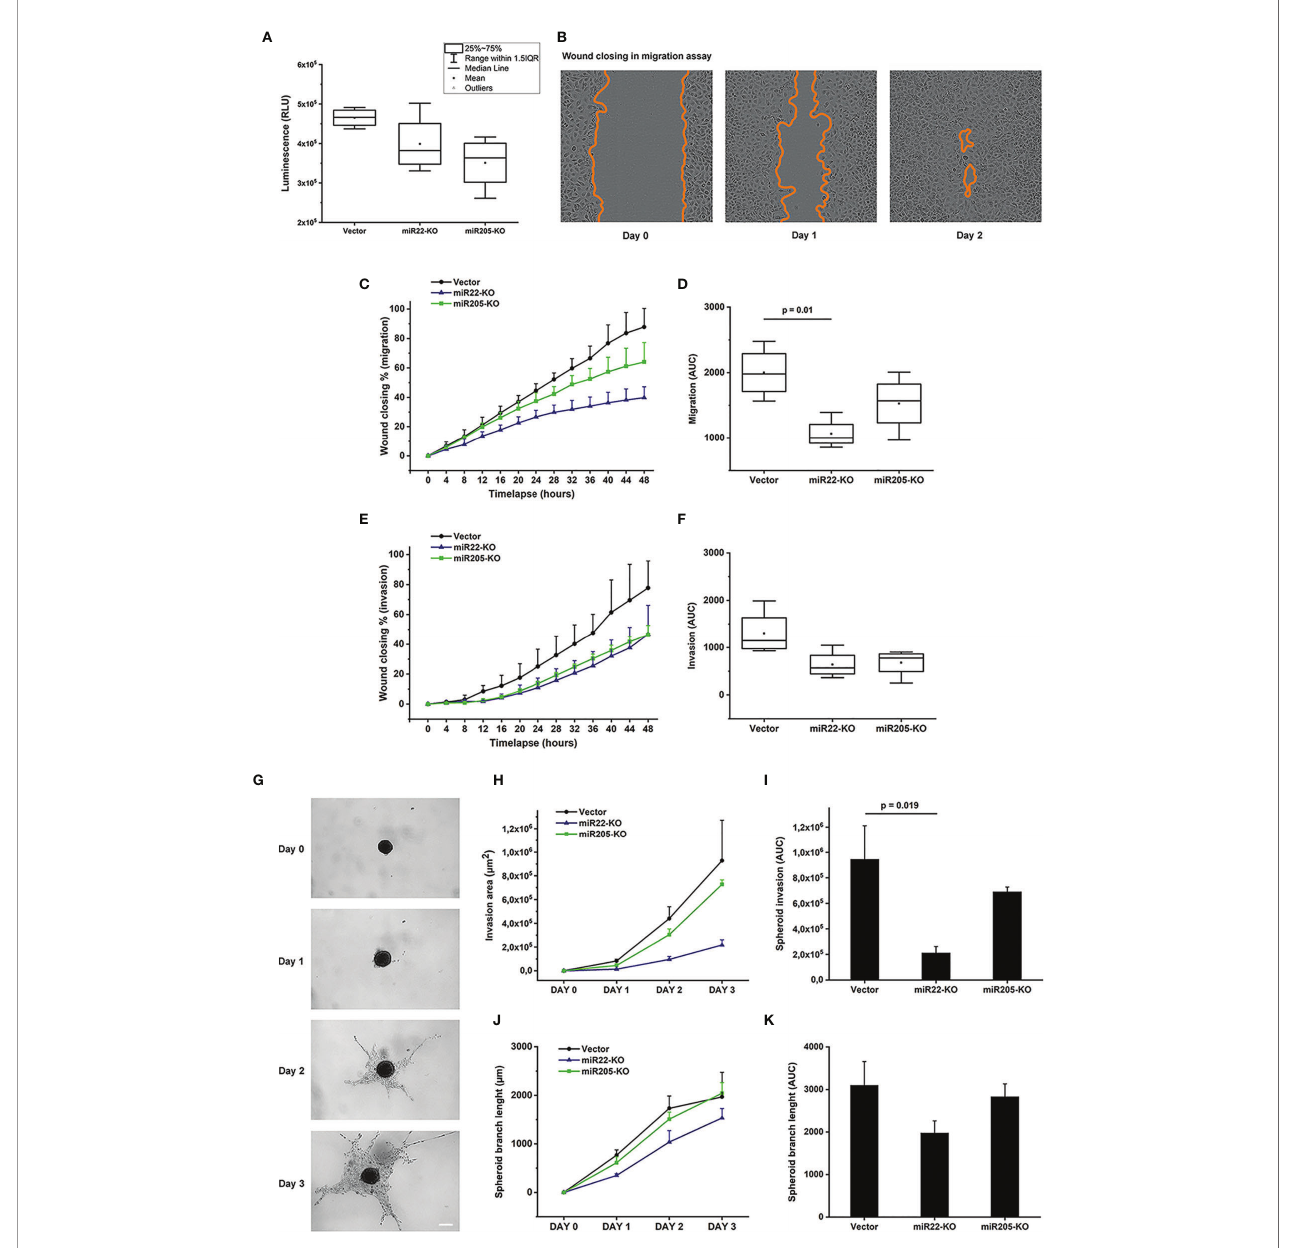
FIGURE 5 | Cell viability, migration and invasion assays performed using the UM-HMC-2 cell line. (A) UM-HMC-2 cells were cultured for three days and the cell viability was measured using luminescent cell viability assay. Although not statistically signi fi cant, the cell viability was decreased in both miR22- and miR205- knockout cell lines compared to the cell line transfected with an empty plasmid vector. (B – D) UM-HMC-2 cells were cultured on Myogel matrix and cell migration was evaluated using scratch wound cell migration assay. (B) Representative image of migration distance at 0, 24, and 48 hours after wounding. (C, D) Quanti fi cation of cell migration in scratch wound assay. miR22- and miR205-knockout cell lines migrated slower than the vector cell line. Statistically signi fi cant difference was denoted between vector and miR22-KO cell lines. (E, F) UM-HMC-2 cell invasion through Myogel-collagen in scratch wound cell invasion assay. UM-HMC-2 cells were cultured in Myogel-collagen matrix, and cell invasion was evaluated using scratch wound cell invasion assay. miR22- and miR205-knockout cell lines invaded slower than vector cell line (p-value > 0.05). (G – K) UM-HMC-2 cell invasion through Myogel- fi brin in spheroid invasion assay. Cells were cultured in U-shaped ultra- low attachment 96-well plate wells and embedded in Myogel- fi brin matrix. Spheroids were observed under a light microscope and the invasion area and the spheroid branch length were analyzed using ilastik and ImageJ software. (G) Representative images of spheroid invasion at different time points. Scale bar = 200 m m (Original magni fi cation X4). (H, I) Quanti fi cation of cell invasion in 3D spheroid invasion assay. Knockout of miR22 and miR205 reduced tumor cell invasion. Difference between vector and miR22-KO cell lines reached statistical signi fi cance. (J, K) Quanti fi cation of spheroid branch length revealed that miR22- and miR205-knockout cell line spheroids did not extend as far as vector cell line (p-value > 0.05). Data are presented as means ± SD of 3-4 independent experiments, each at least in triplicate. p < 0.05 is considered as signi fi cantly different compared to vector